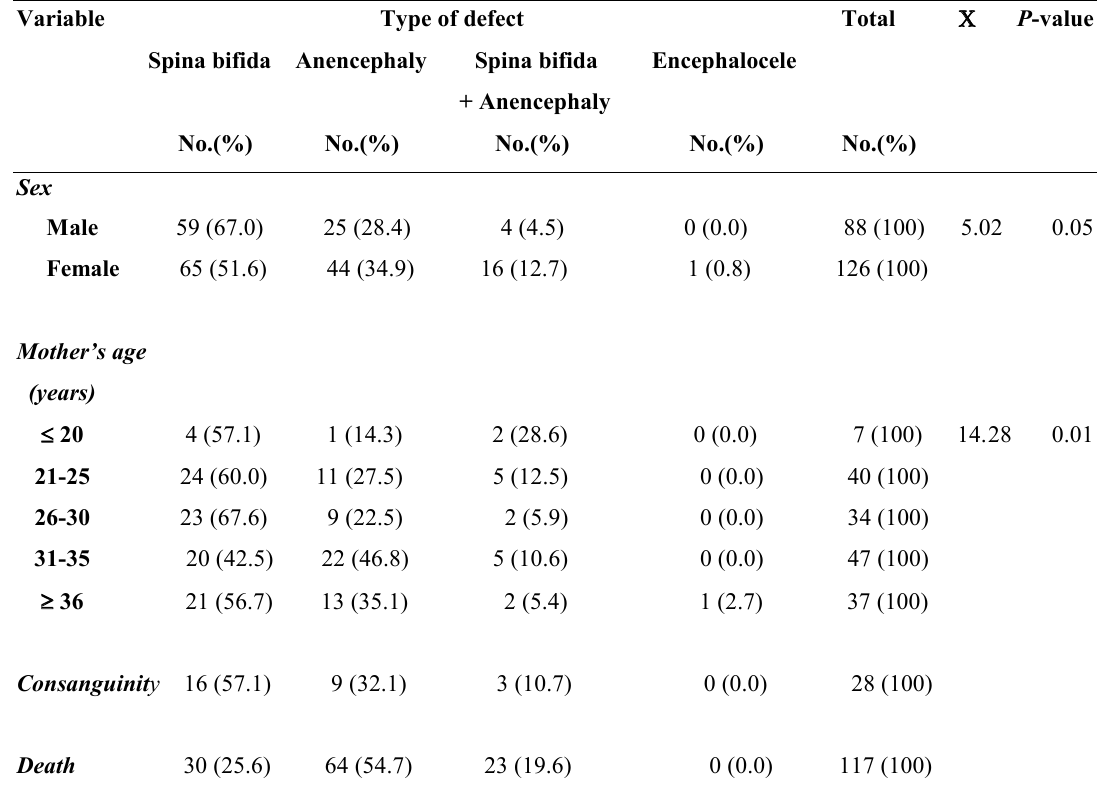
Table 1. Characteristics of cohorts of the different types of NTD registered in Sétif (Algeria), 2004-2006.